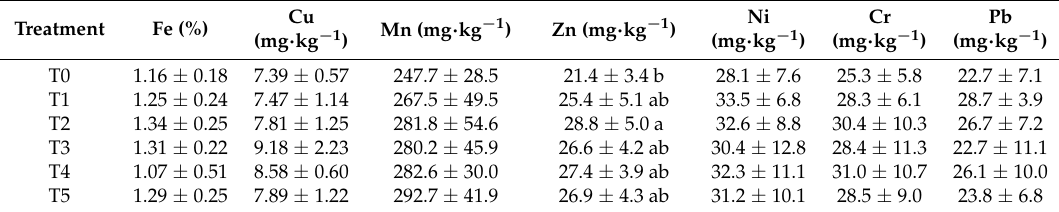
Table 4. Heavy metals content in the soil depending on the fertilization treatment after the three-year application